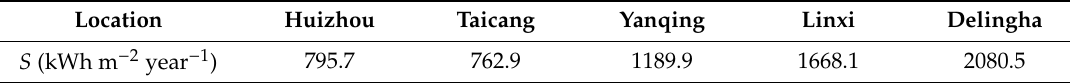
Table 4. Annual DNIs of di ff erent